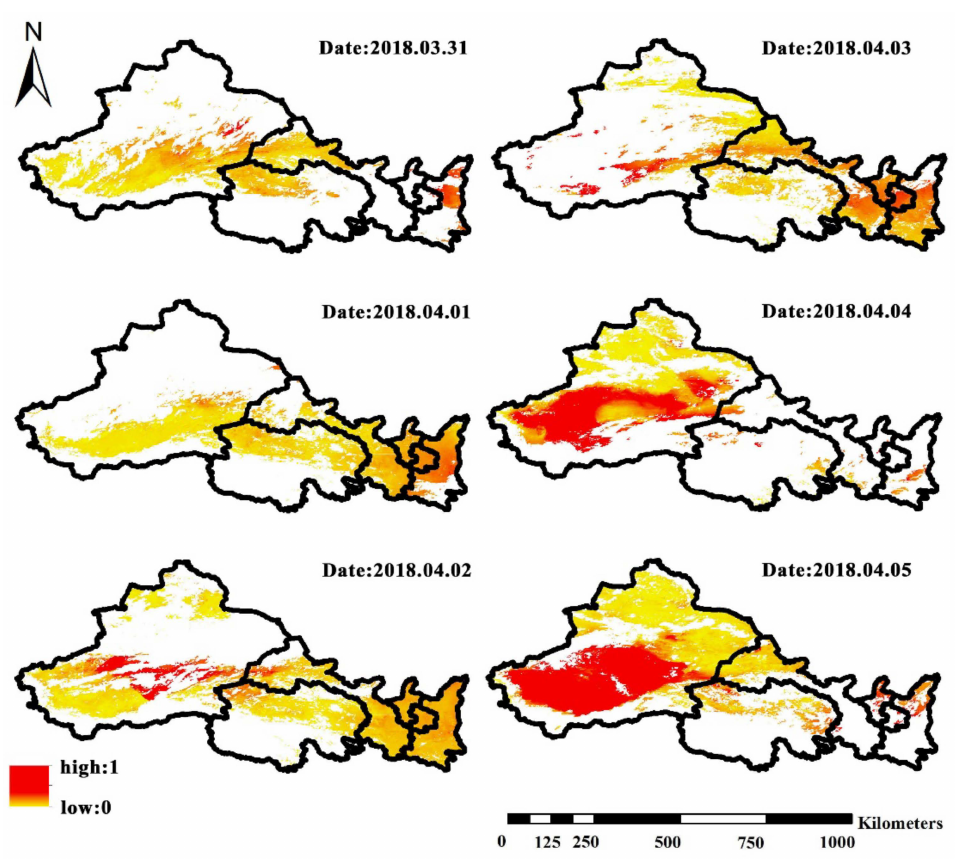
Figure 3. Spatial distribution of daily mean AOD at 550 nm during the period relevant to the sandstorm event in April 2018, for the case study